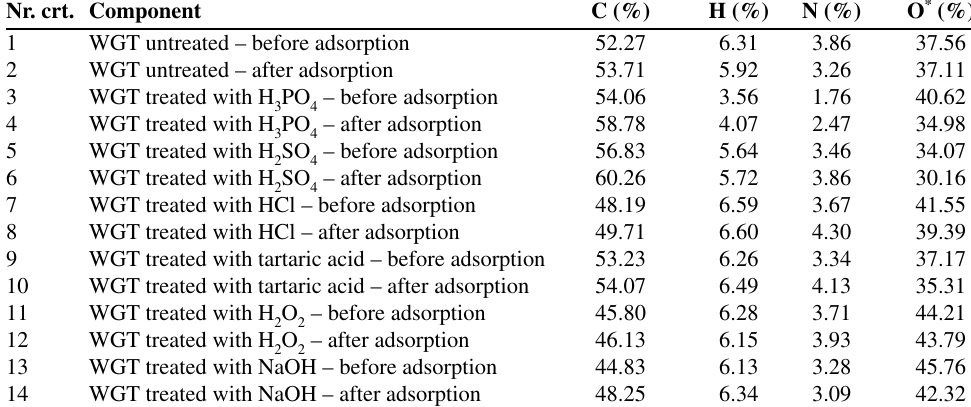
Table 1. Elemental analysis of WGT untreated and chemically modified, before and after MG adsorption (1% error) Nr. crt. Component